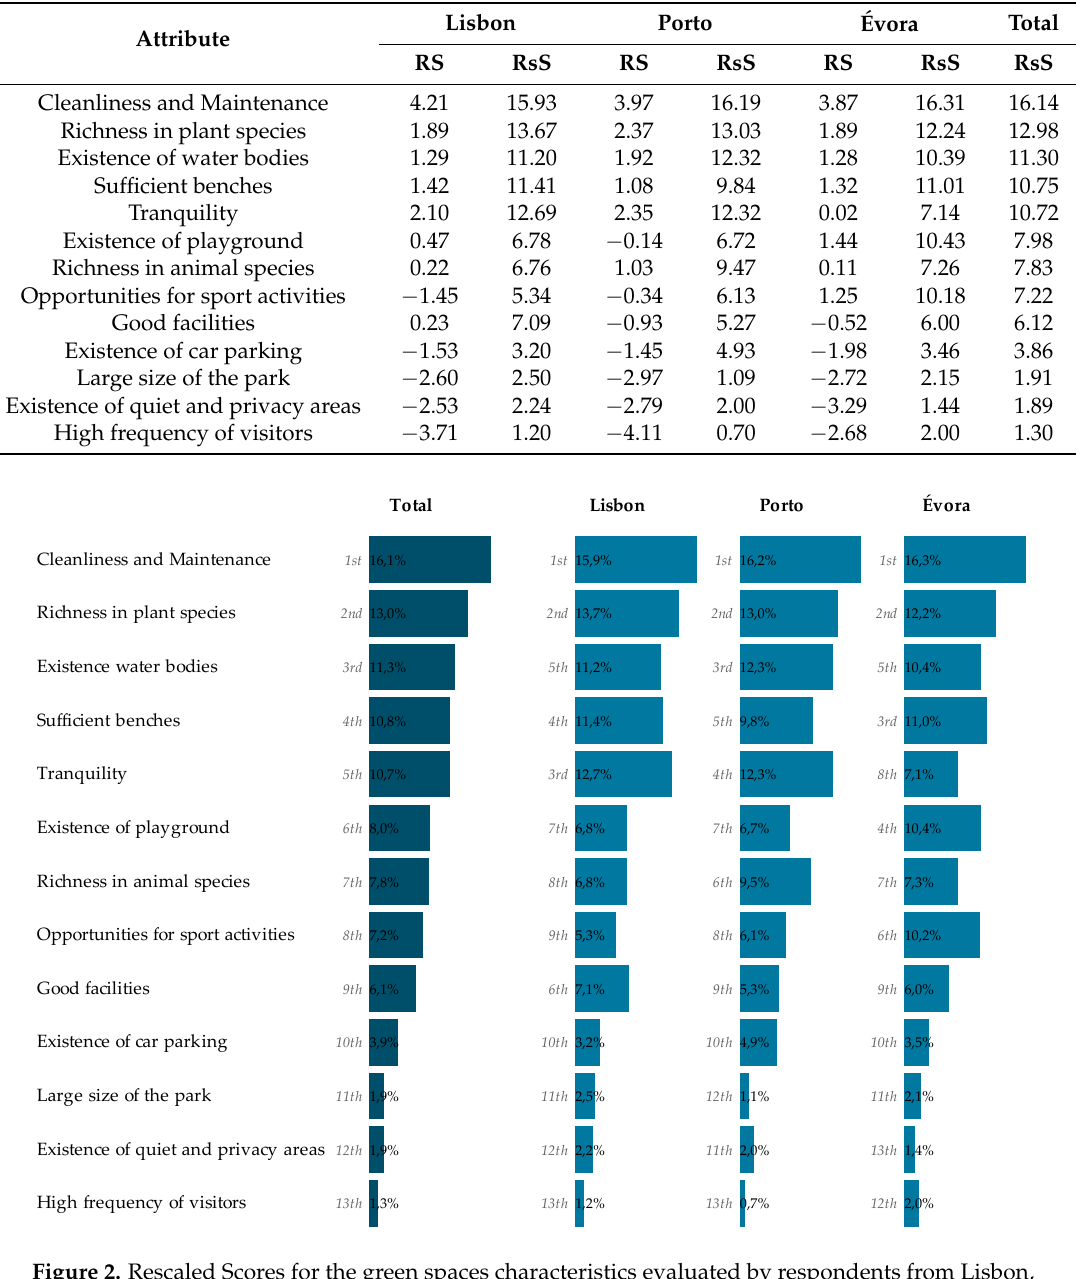
Table 3. Raw Scores (RS) and Rescaled scores (RsS) relating to the thirteen attributes.